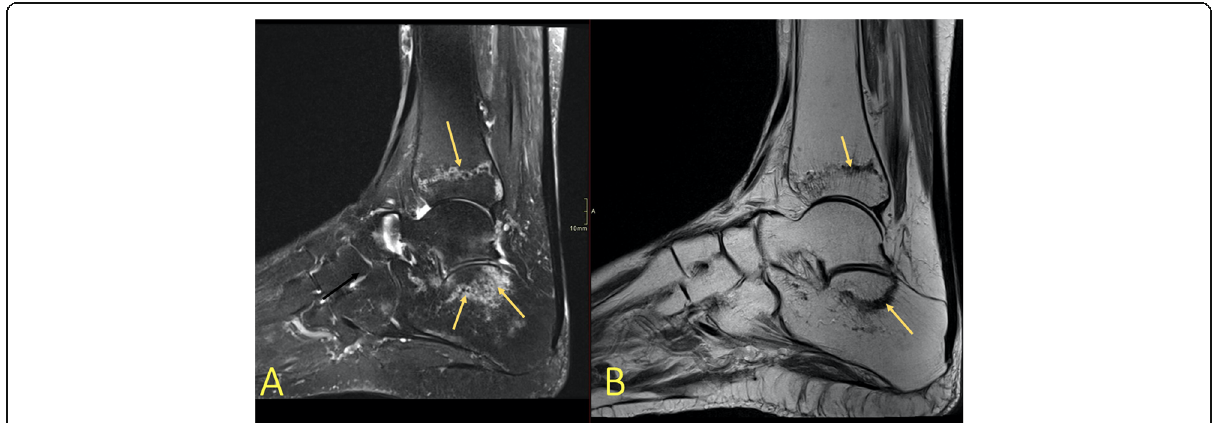
Fig. 13 A 57-year-old female with hindfoot pain for 4 weeks and a suspected osteochondral lesion and osteoarthritis. MRI showed stress fractures of the tibia and calcaneus (arrows)